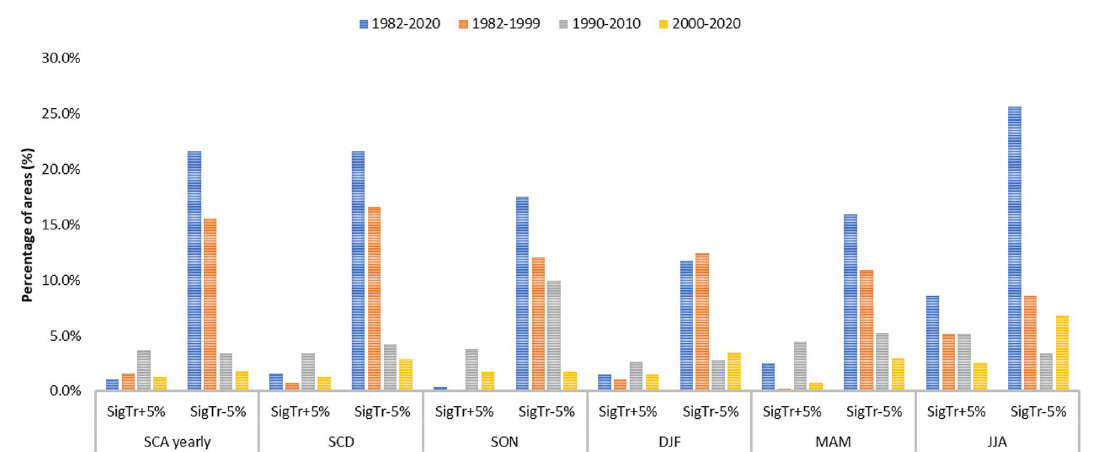
Figure 3. Percentage of areas with significant trends. Percentage of areas with respect to the total number of areas with significant positive and negative trends for the long-term period (1982–2020) and the three sub- periods analyzed (1982–2000, 1990–2010,